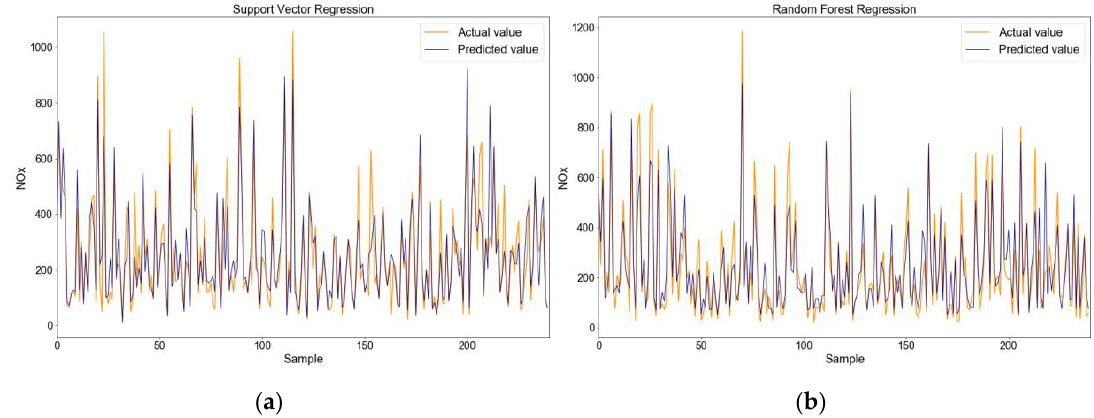
Figure 5. Scatterplots of the actual values and the predicted values (10% testing instances randomly): ( a ) SVR model, ( b ) RFR model.